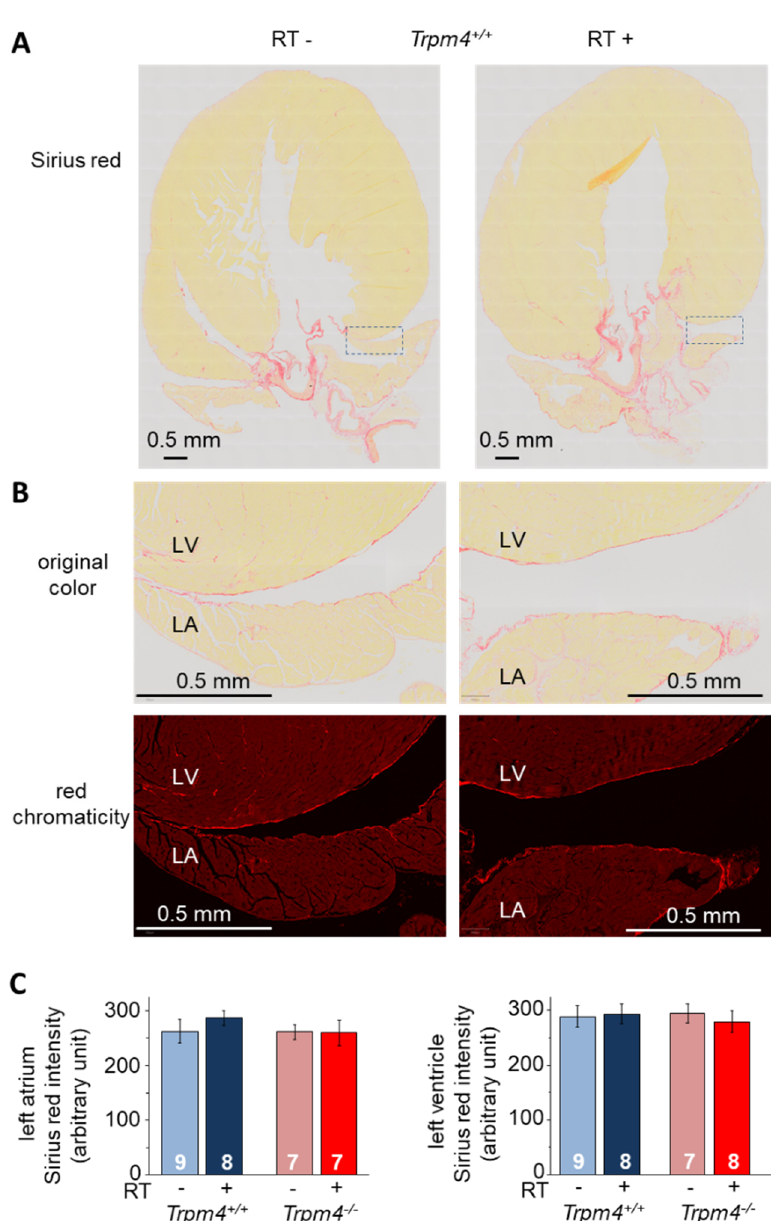
Figure 8. No effect of irradiation on atrial and ventricular fibrosis. ( A ) Histological slices performed at 5 months post-treatment in the longitudinal axis (3 µ m thickness) of the whole heart for representative RT − and RT+ Trpm4 +/+ animals. Slices were stained with Sirius red to reveal fibrosis. ( B ) Magnification of the area indicated in A by dotted lines to reveal the left atrium and ventricle. The upper images are in full color while the bottom images are shown in red chromaticity mode (see methods) to precisely isolate Sirius red staining. For each image, the left ventricle (LV) is on the upper side while the left atrium (LA) is on the lower side. ( C ) The left atrium ( left ) and left ventricle ( right ) red chromaticity intensity after Sirius red staining for each group in arbitrary units (see methods for quantification protocol). Data indicate the mean ± S.E.M. for each